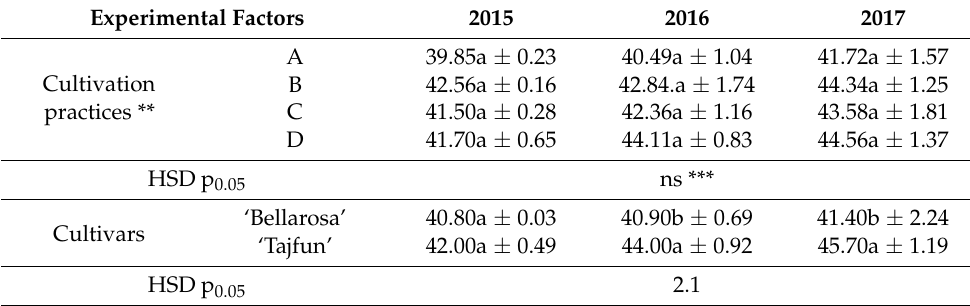
Table 8. Effects of cultivation practices, cultivars, and years on the b* parameter. Experimental Factors